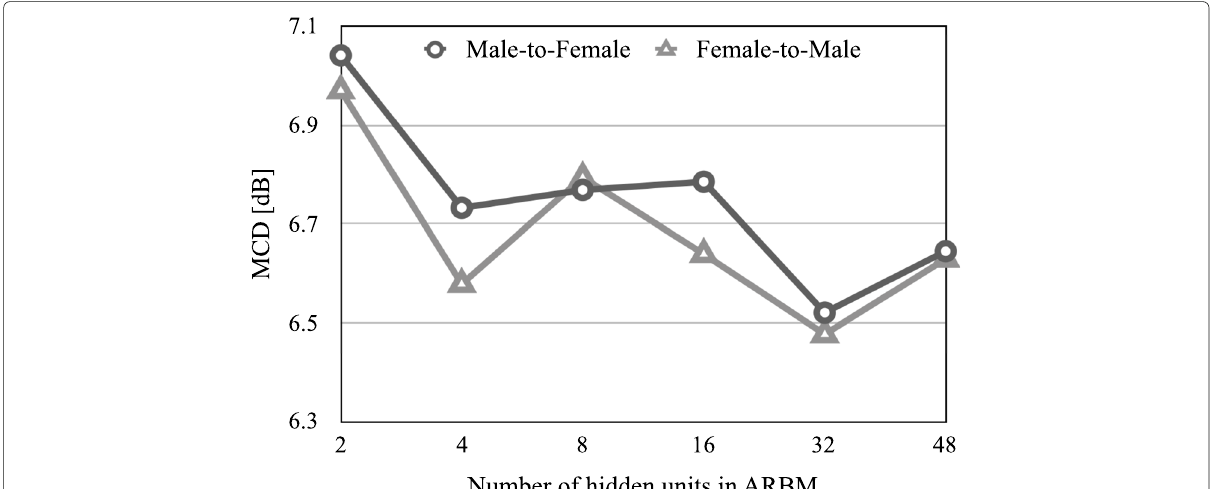
Fig. 4 Average MCD [dB] of the conventional ARBM-based VC when varying the number of hidden